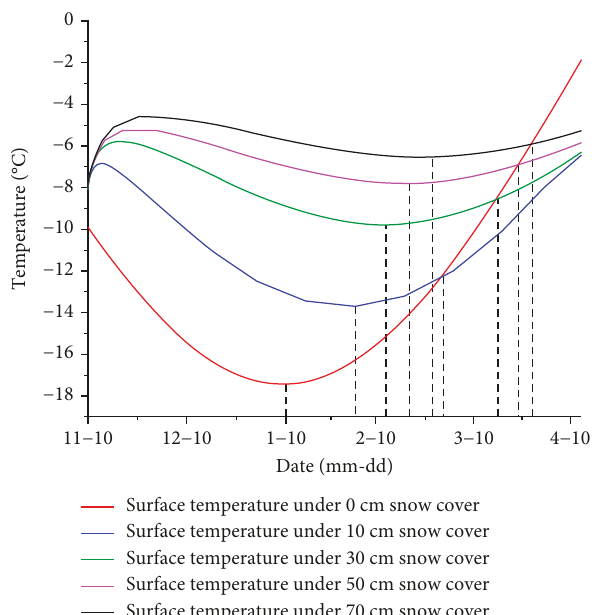
Figure 7: The surface temperature under different depths of snow